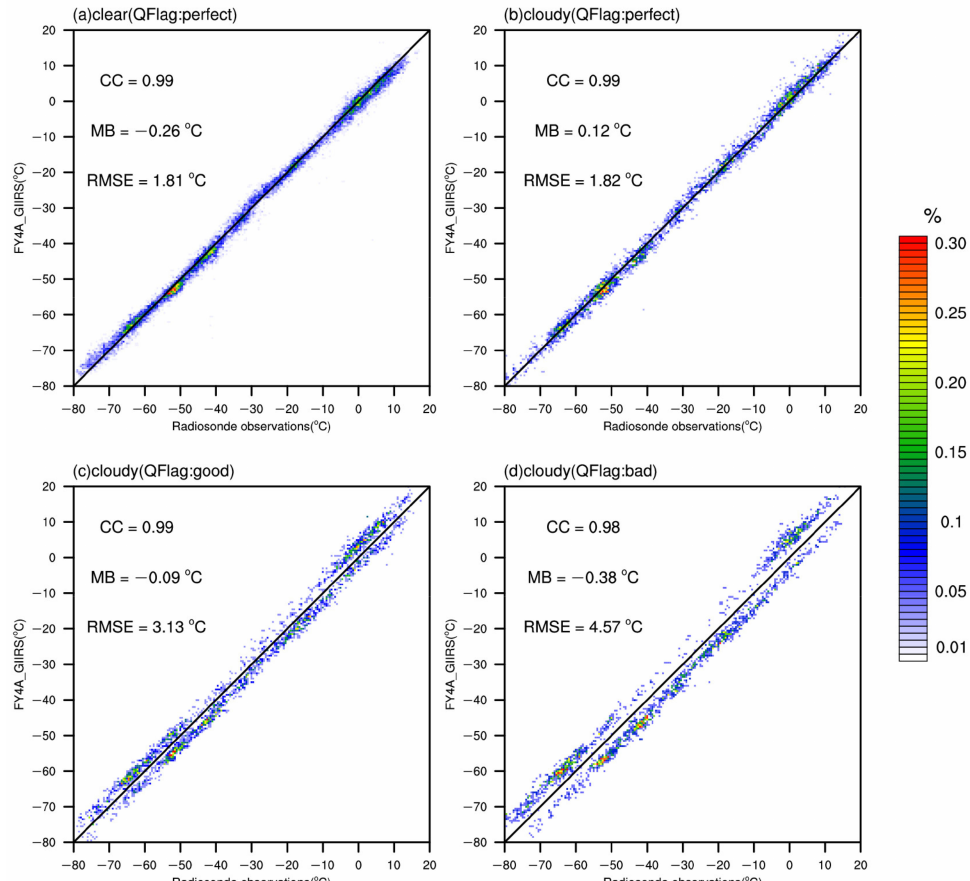
Figure 3. Density scatterplots for GIIRS atmospheric temperature profile products vs. the radiosonde observations. ( a ) the perfect flagged samples under the clear sky; ( b ) the perfect flagged samples under the cloudy sky; ( c ) the good flagged samples under the cloudy sky; ( d ) the bad flagged samples under the cloudy sky. The occurrence frequency represents the percentage with respect to the total samples of the number (perfect flagged samples under the clear sky, good flagged samples and bad flagged samples under the cloudy sky) lying in each grid area with an interval of 0.5 ◦ C. The color bar indicates the occurrence frequency (%) lying with in each grid area. The black line is the 1:1